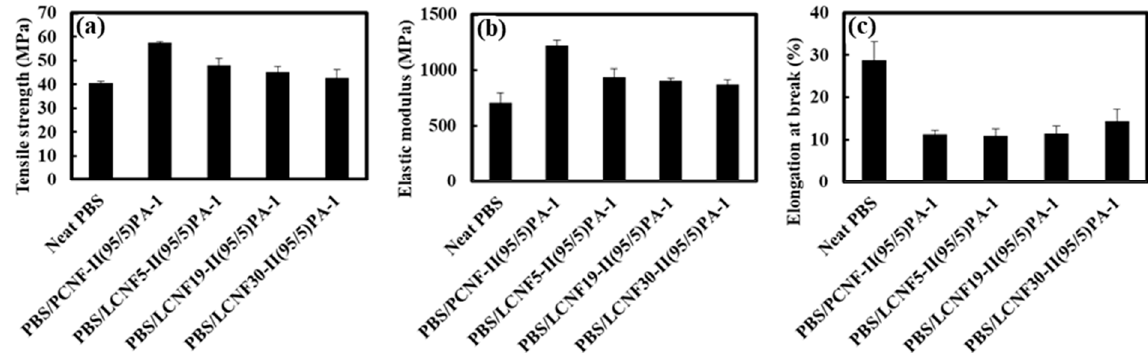
Figure 7. Tensile strength ( a ), elastic modulus ( b ), and elongation at break ( c ) of neat PBS, PBS/PCNF, and PBS/LCNF with different lignin content.